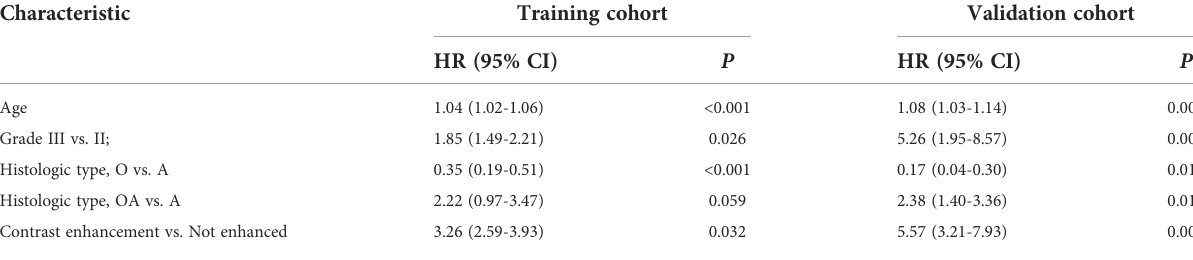
TABLE 4 Multivariate Cox regression analyses of clinical data for overall survival in the training and validation cohorts of patients with LGG.